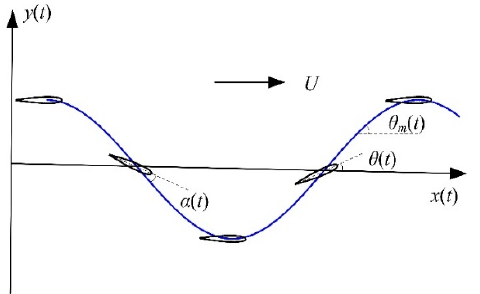
Figure 2. Definition of variables.